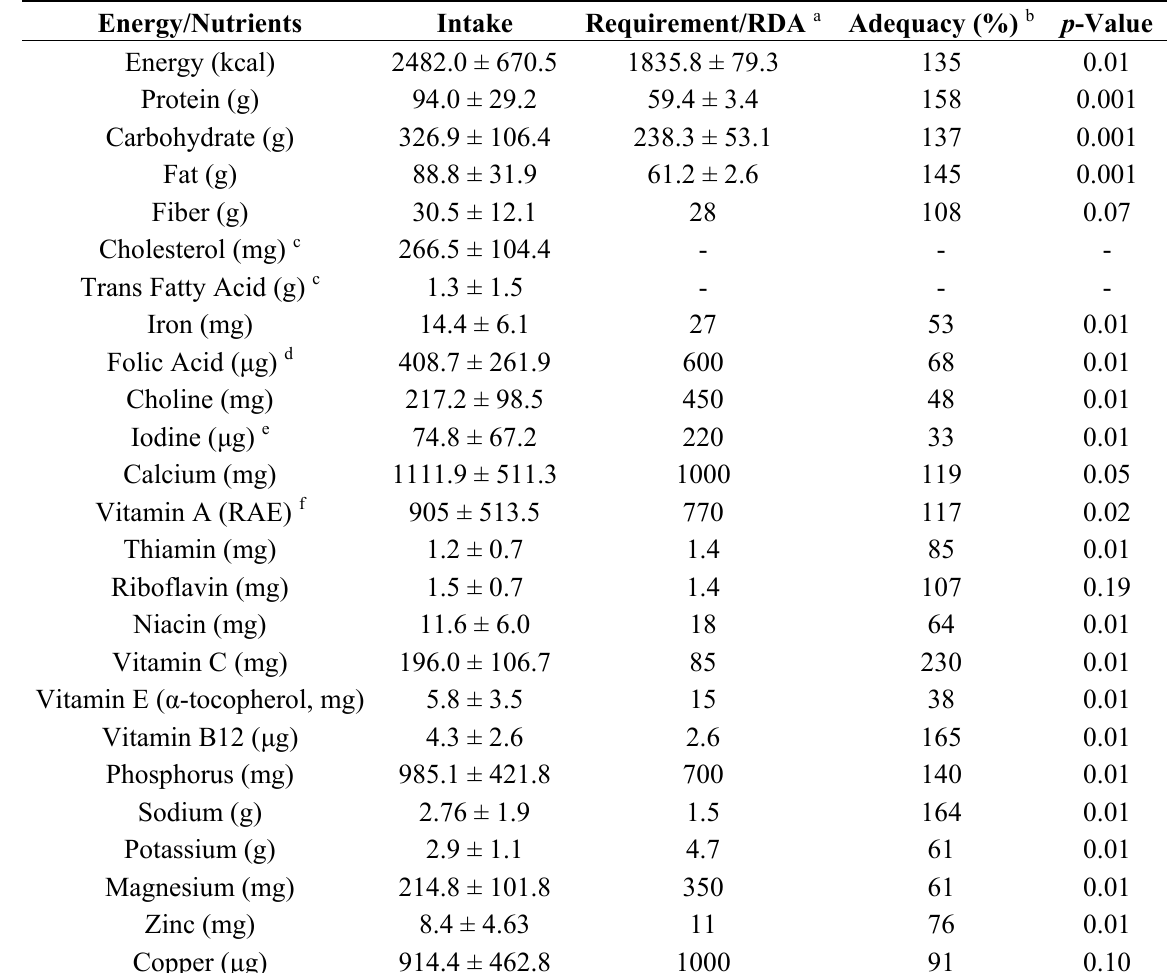
Table 2. Daily energy and nutrient dietary